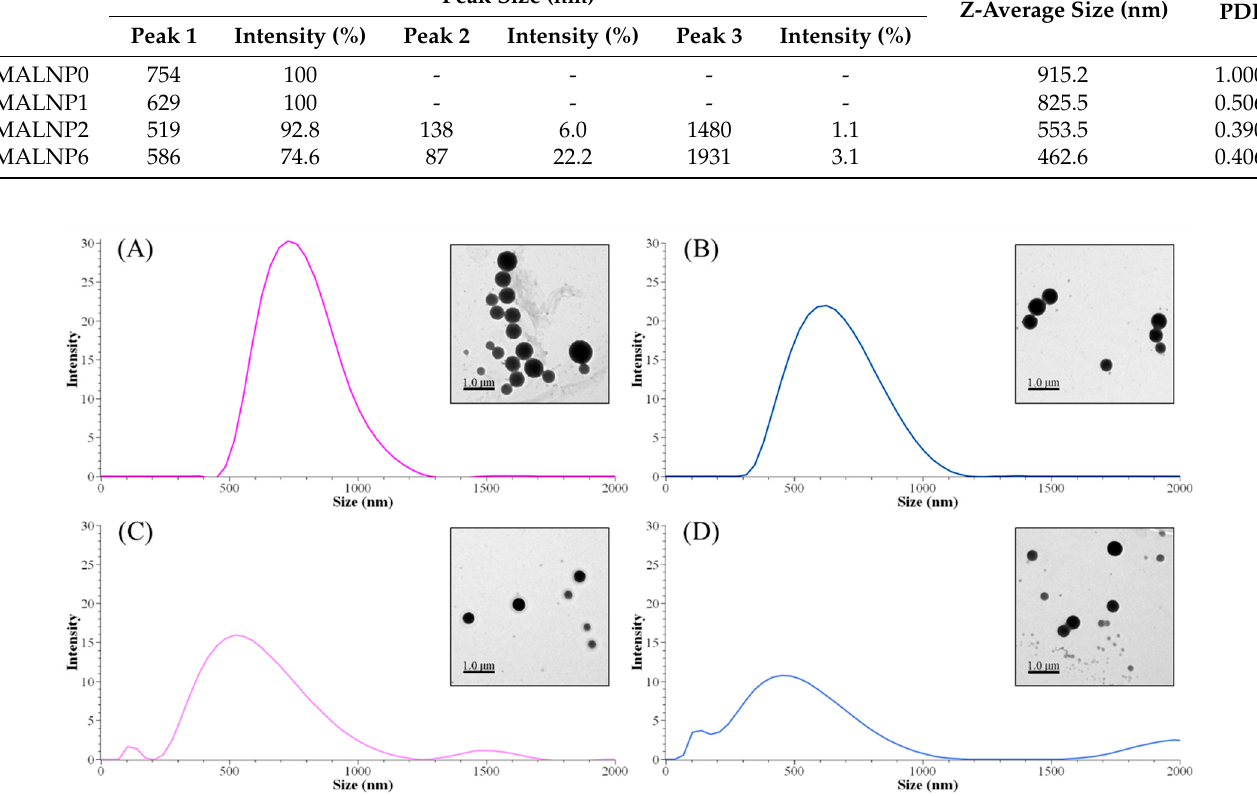
Table 6. Size properties of methylated AL-derived nanoparticles.